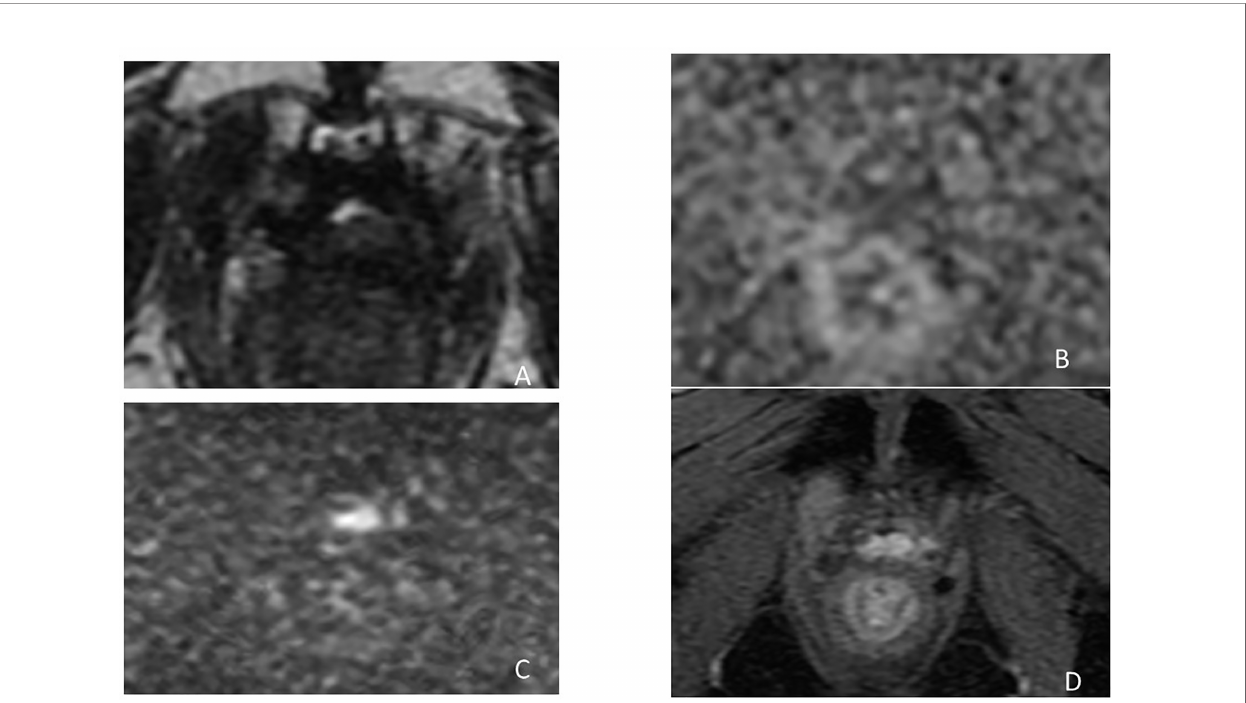
FIGURE 4 | Postsurgical lesion recurrence (arrows) in a 63-year-old male with serum PSA = 0.6 ng/ml after radical prostatectomy. Axial T2W MRI (A) , ADC map (B) , b2000 DW MRI (C) , and DCE MRI (D) show a soft tissue lesion at the posterior part of VUA, relatively hyperintense on T2W best seen on high b -value and DCE imaging with a focal nodular enhancement that contrasts sharply with the general background low-level venous